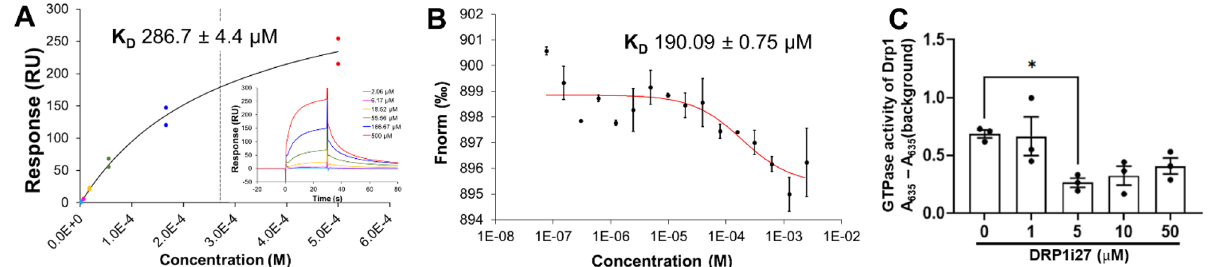
Figure 4. DRP1i27 directly binds to and inhibits GTPase activity of human Drp1. ( A ) Representative fitted and raw data of SPR and ( B ) MST showing binding response of DRP1i27 to human Drp1 isoform 3 (n = 2). ( C ) The effect of DRP1i27 on Drp1 GTPase activity (n = 3). Data are expressed as mean ± SEM. * p ≤ 0.05 vs DMSO by one-way ANOVA with Bonferroni post hoc